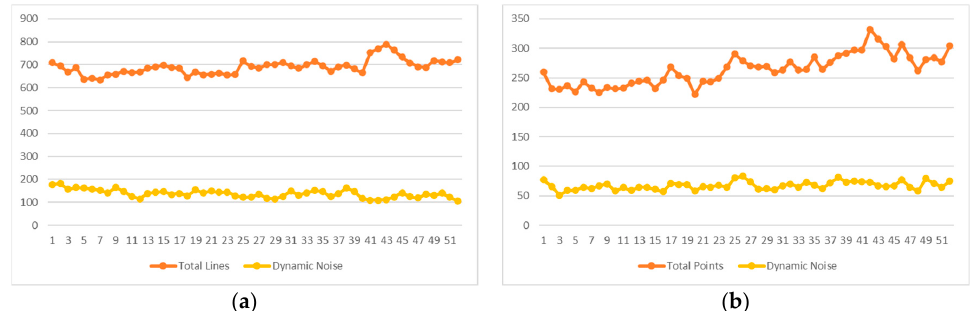
Figure 7. Point line feature dynamic noise statistics on KITTI dataset. The horizontal coordinate represents the frame number, and the vertical coordinate represents the number of features. ( a ) Line Feature Dynamic Noise Statistics. ( b ) Point Feature Dynamic Noise